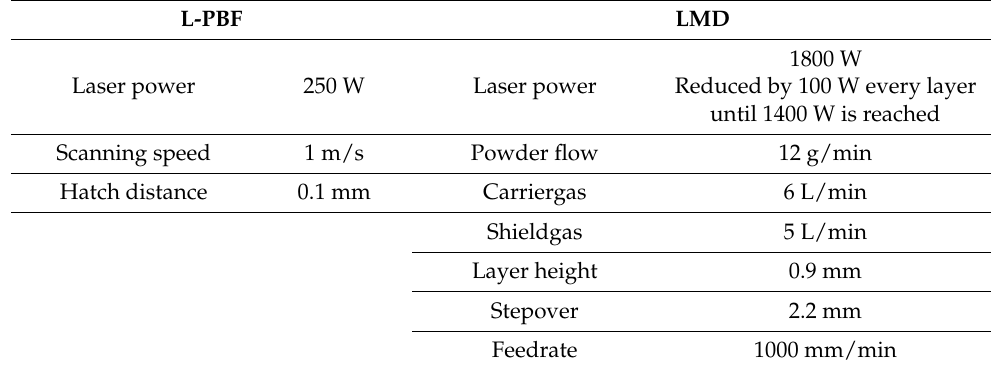
Table 1. Process parameters for L-PBF and LMD used for producing all samples.